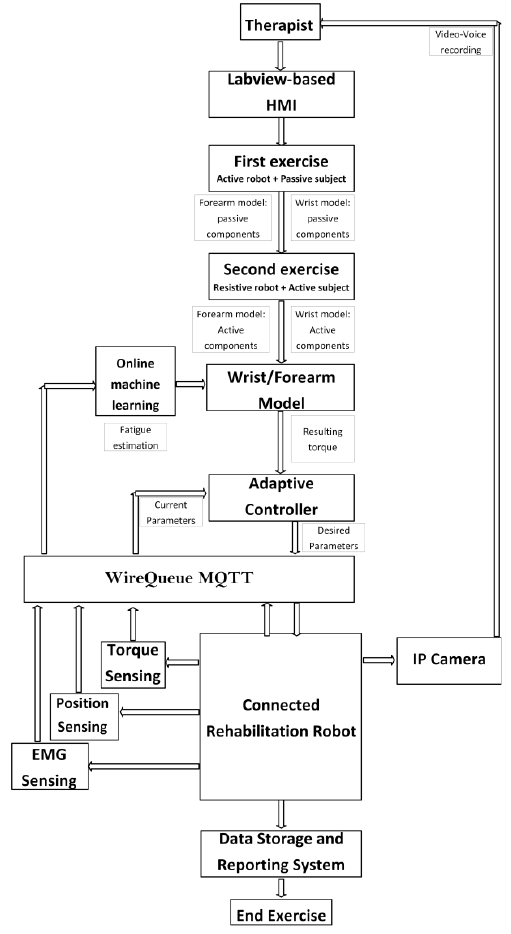
Figure 11. Operating system flowchart.